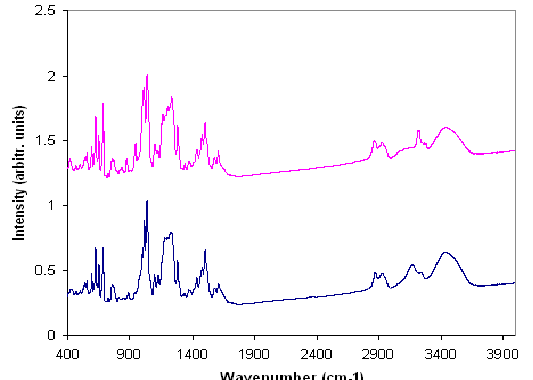
Figure 5. Experimental infrared spectra recorded in solid state of